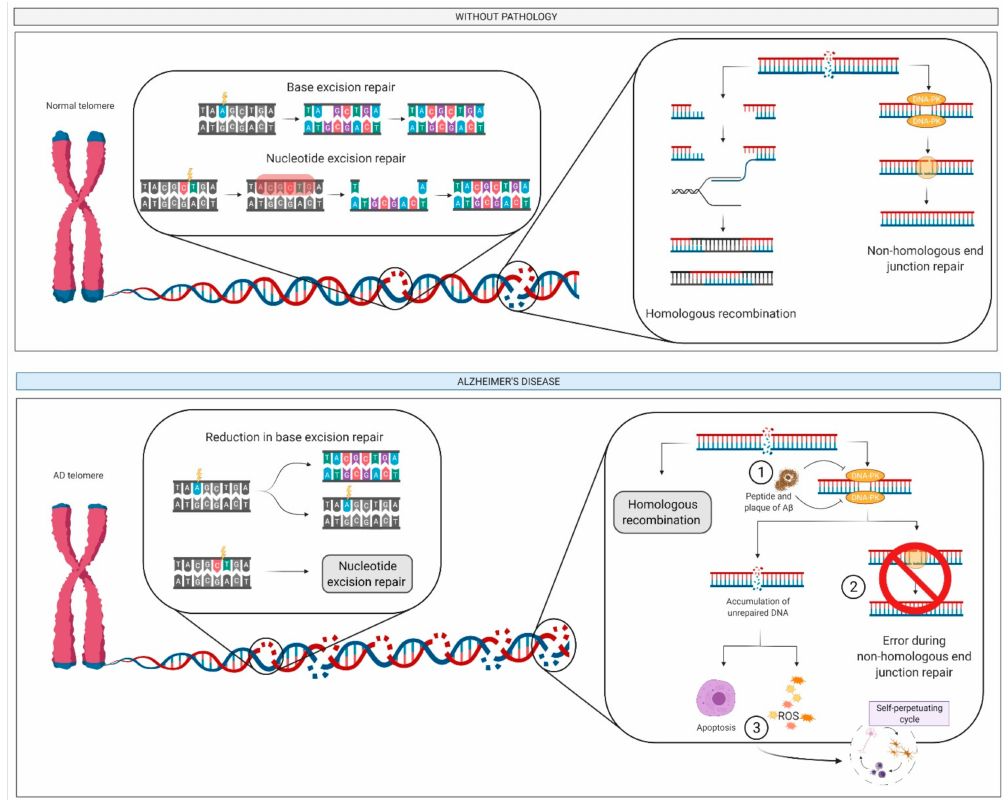
Figure 7. DNA: damage and repair pathways. The deposition of A β peptides (step 1) can difficult the non-homologous end junction repair (step 2) leading to the accumulation of numerous lesions of DNA, resulting in apoptosis and ROS generation (step 3). This can activate the self-perpetuating cycle of AD. Abbreviation: A β , amyloid beta; AD, Alzheimer’s disease; DNA, deoxyribonucleic acid; ROS, reactive oxygen